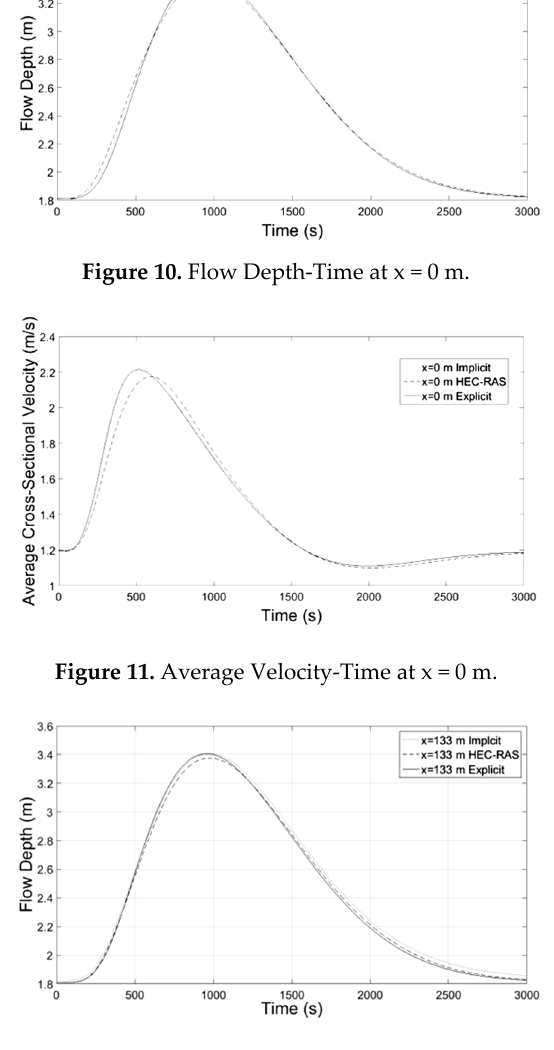
Figure 12. Flow Depth-Time at x = 133